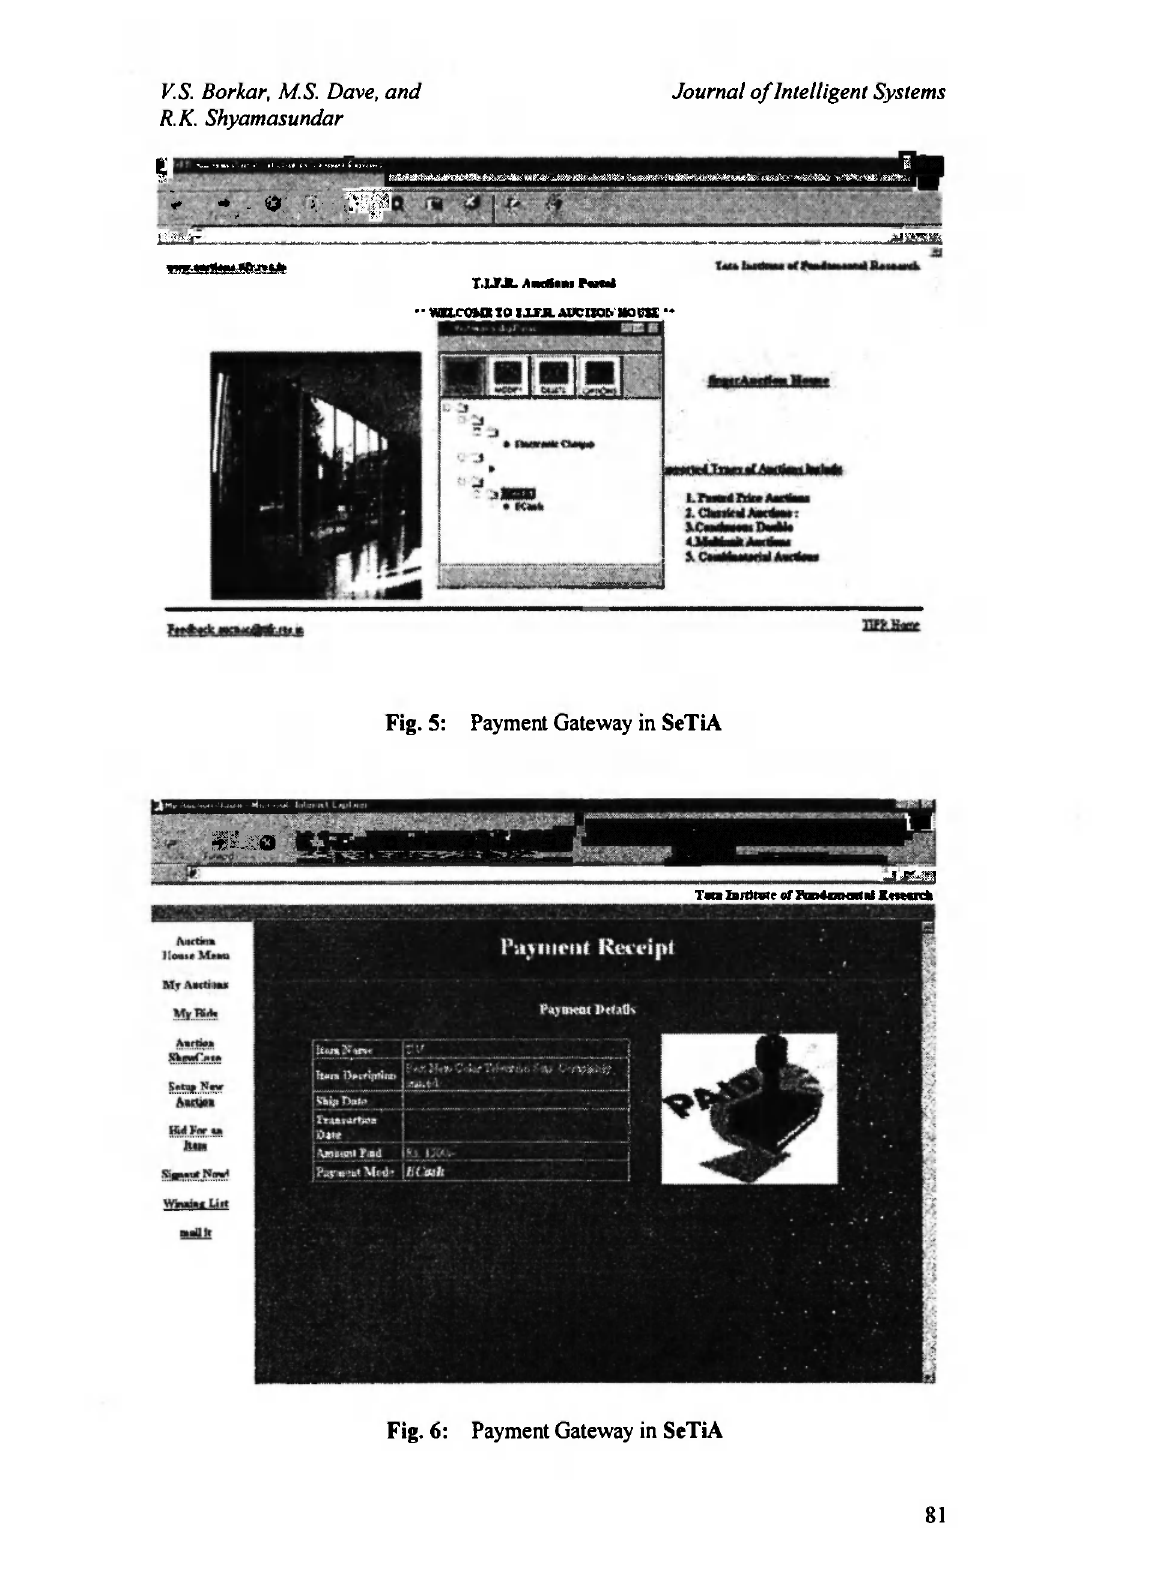
Fig. 6: Payment Gateway in